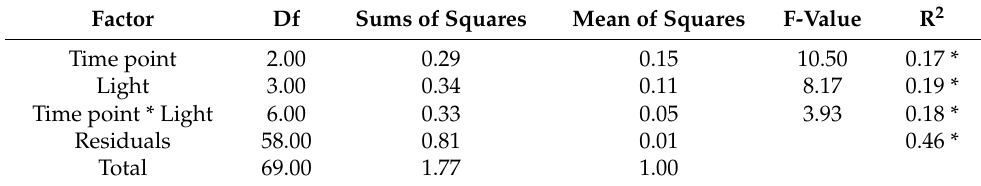
Table 3. Effects of light and time on the metabolites in Hapalosiphon sp. (MRB 220))—PerMANOVA.